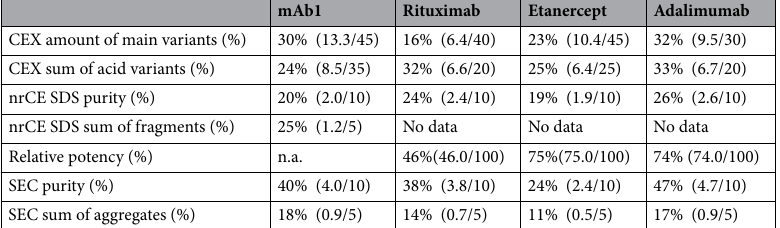
human studies, and their quotient expressed in%. Generic specifications for potency, purity, aggregation and fragmentation are defined as absolute values in the guidelines as acceptance criteria for mAb drug substance and drug product 48 ( relative potency not less than 50% and not more than 150%, SEC purity not less than 90.0%, SEC sum of aggregates not more than 5.0% and nrCE SDS purity not less than 90.0%). For acceptance criteria of nrCE SDS sum of fragments authors suggest to report result or not more than x.x % limit where in analogy to sum of aggregates a criteria was set to not more than 5.0% ).Generic specifications for charge variant profiles are molecule-dependent and thus there is no clear target values that can be broadly applied as platform acceptance criteria. In presented study acceptance criteria for charge variant are set for 10% wider as than the observed results as an option proposed by Kretsinger et al. 48 . Namely, acceptance criterion for sum of acidic variants is “less than its initial value + 10%”, while acceptance criterion for amount of main variant is “more than its initial value -10%”. Initial values were calculated as an average of all batches of a molecule at pull point t = 0 and rounded to the nearest five. As shown in Table 2 calculated model-based prediction intervals at 36 month time point are substantially narrower compared to the generic specifications for all quality attributes and for all studied molecules. Despite the narrowness of the prediction intervals, we still achieved better than 90% accuracy of prediction of all stability quality attributes (Table 1). Prediction accuracy of kinetic modelling vs. linear extrapolation. According to ICH guidelines 41 stability profiles and shelf-life are determined by using linear regression models of measured data at intended conditions. To compare the kinetic modelling approach with the linear extrapolation we evaluated the same experimental data as above with the linear extrapolation approach. We compared accuracy of the prediction and prediction intervals for different extrapolated time periods. Specifically, we calculated prediction intervals with kinetic modelling and with linear extrapolation by using 3, 6, 12, 18 or 24 months experimental stability data (note: in analyses above only 6 month data was used for prediction calculations). Figure 5 evidently shows that kinetic modelling resulted in narrower prediction intervals compared to linear extrapolation. For example, by using kinetic modelling already after 6 months of stability study the sum of aggregates is predicted to be less than 1% at 36 month intendent condition time point, which is in agreement with the experimental long-term stability